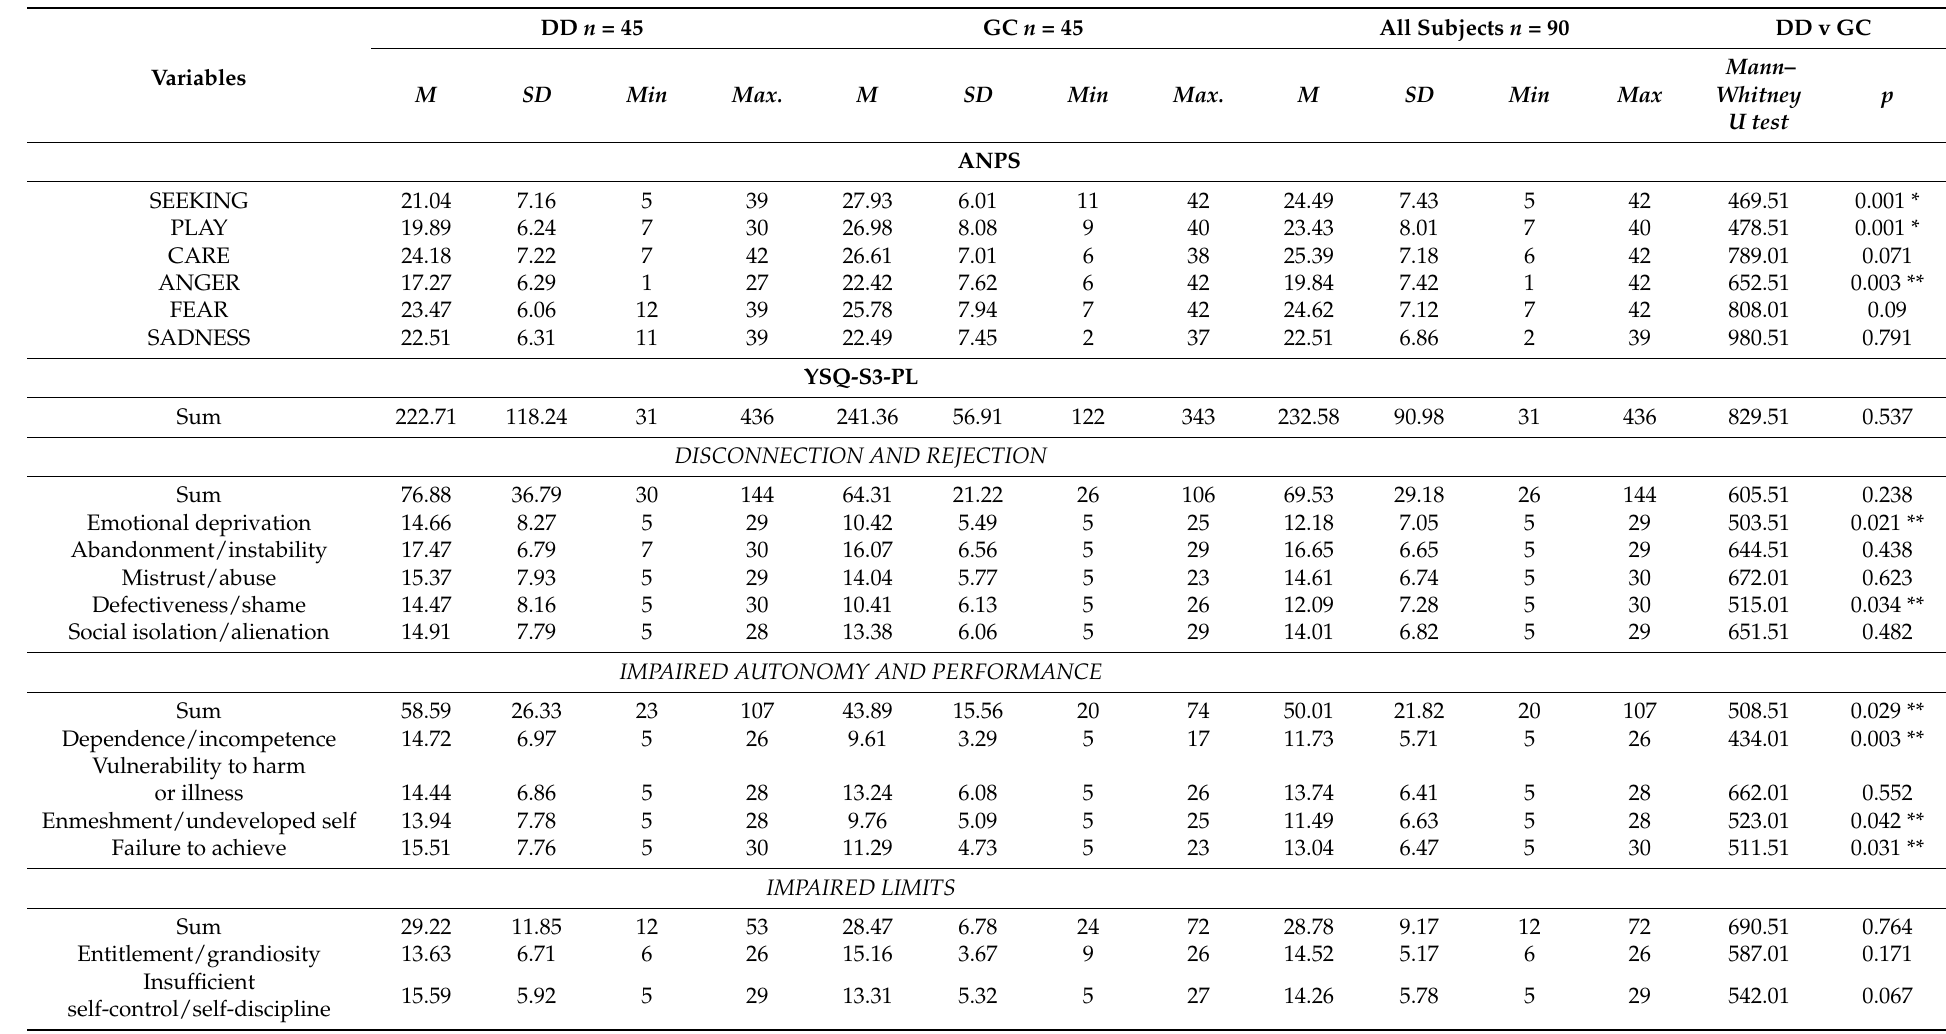
Table 3. Neural emotional systems and early maladaptive schemas across the studied